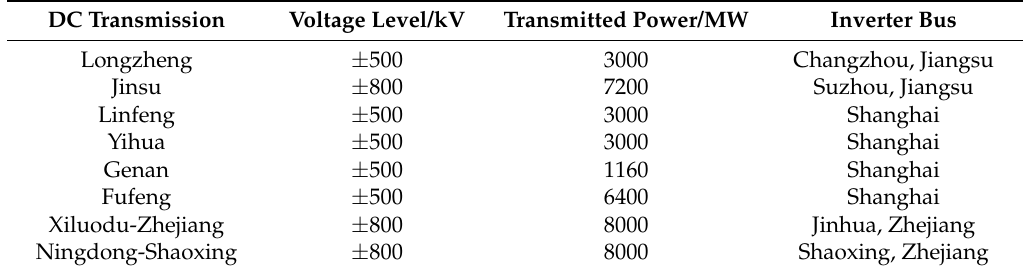
Table 4. High voltage DC and ultra-high voltage DC transmission lines in the Eastern China Grid.